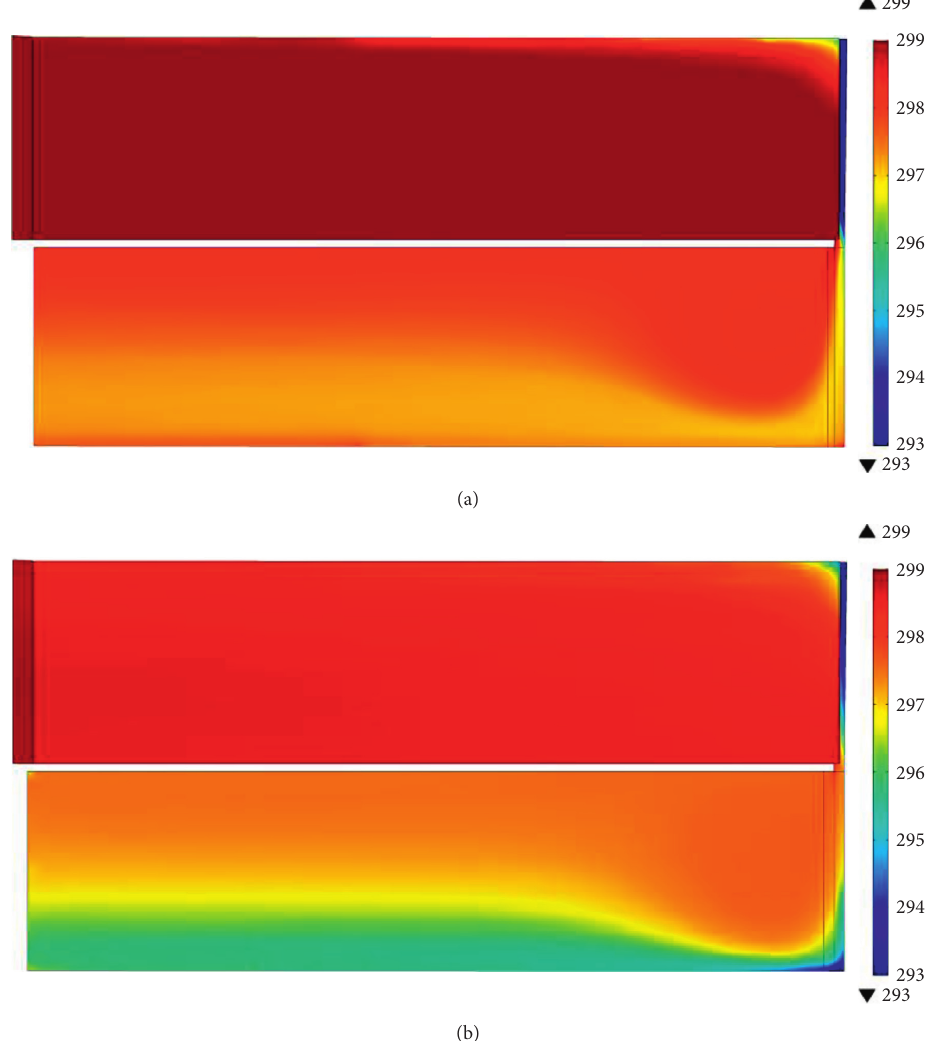
Figure 9: Effect of water depth on air-water surface temperature distribution K for reactor inclined at 1 ° , Re � 9000, and aspect ratio � 180 for (a) 5.6 mm and (b) 10mm in June (XY-plane).